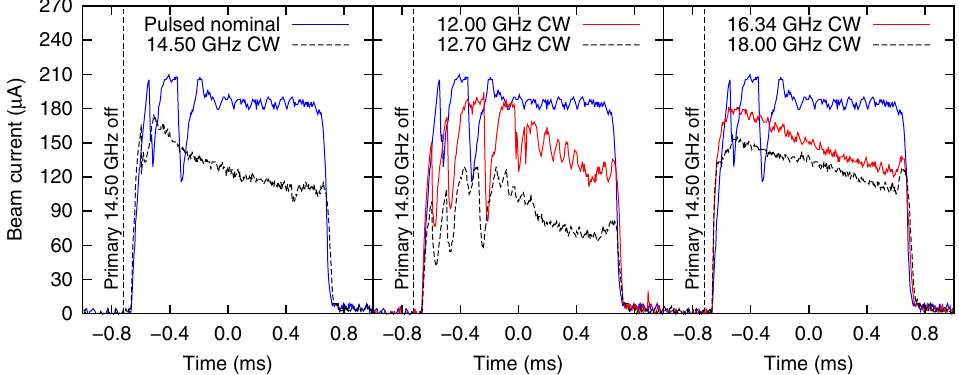
FIG. 7. 208 Pb 29 þ beam current during the afterglow with pulsed primary and CW secondary frequency. The nominal single frequency case ( “ Pulsed nominal ” ) is presented for comparison. The primary 14.50 GHz frequency is supplied at 1930 W in all cases. The secondary frequency powers for 12.00, 12.70, 14.50, 16.34, and 18.00 GHz are 161, 204, 200, 175, and 200 W, respectively.